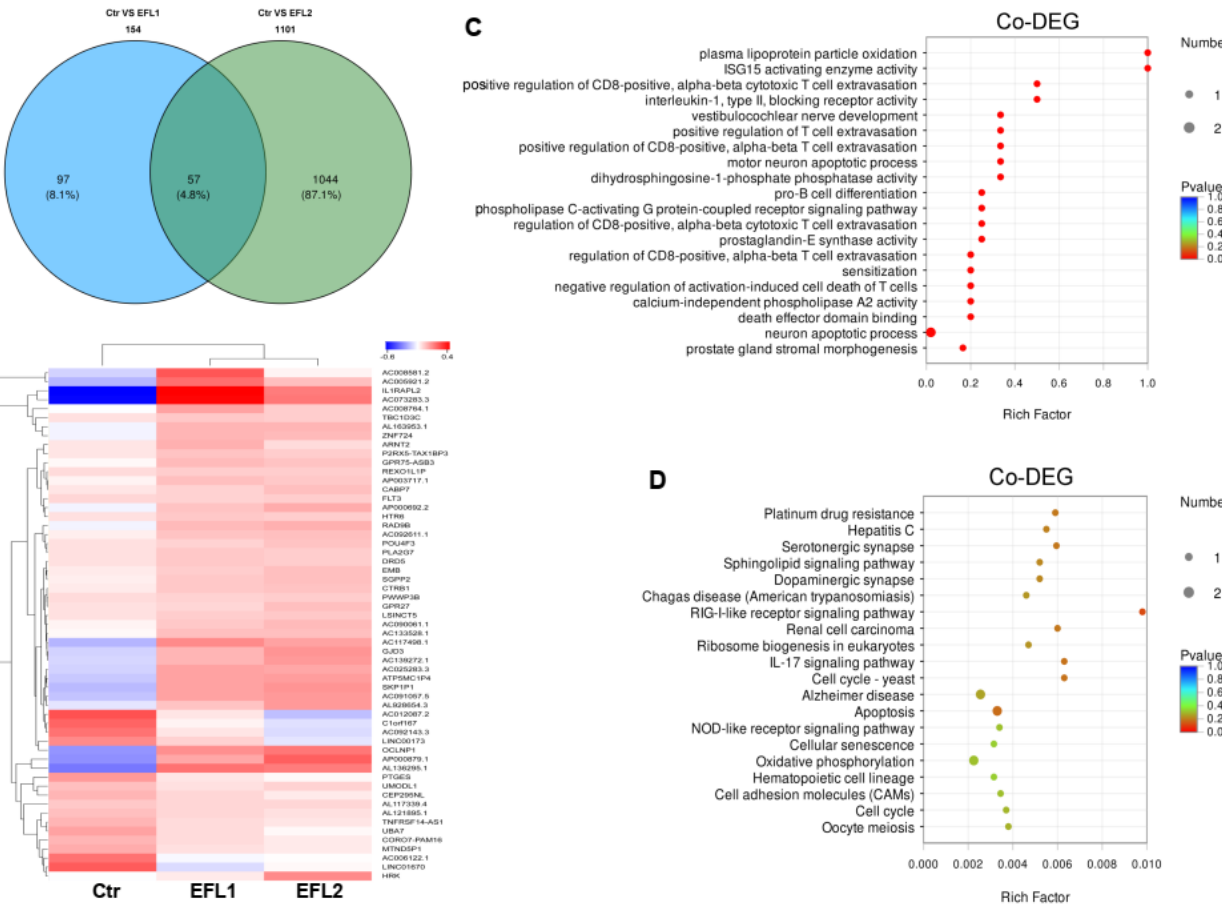
Figure 6. ( A ) The Venn diagram of differentially expressed mRNA in each EFL-treated group. The cluster analysis heat map ( B ), GO ( C ) and KEGG ( D ) enrichment of 57 differentially co-expressed mRNAs.